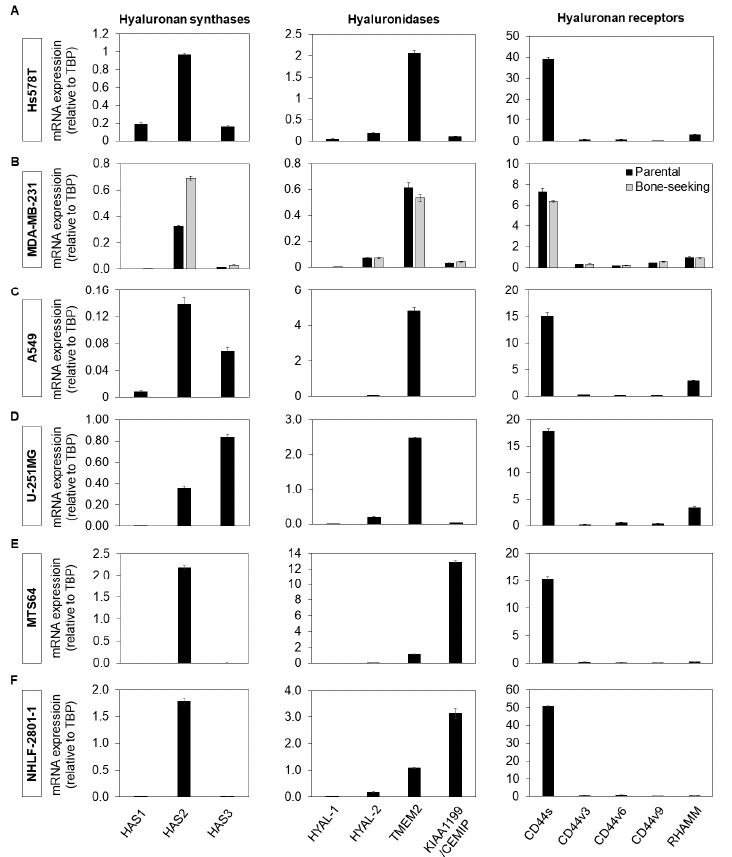
Figure 2. Expression of mRNA for hyaluronan synthases, hyaluronidases and hyaluronan receptors in various cell lines. mRNA expression analysis of hyaluronan synthases, hyaluronidases and hyaluronan receptors using RT-qPCR in Hs578T ( A ), MDA-MB-231 (parental and bone-seeking clone) breast cancer ( B ), A549 lung adenocarcinoma ( C ), U-251MG glioblastoma cells ( D ), and MTS64 dermal ( E ) and NHLF-2801-1 ( F ) lung fibroblasts.